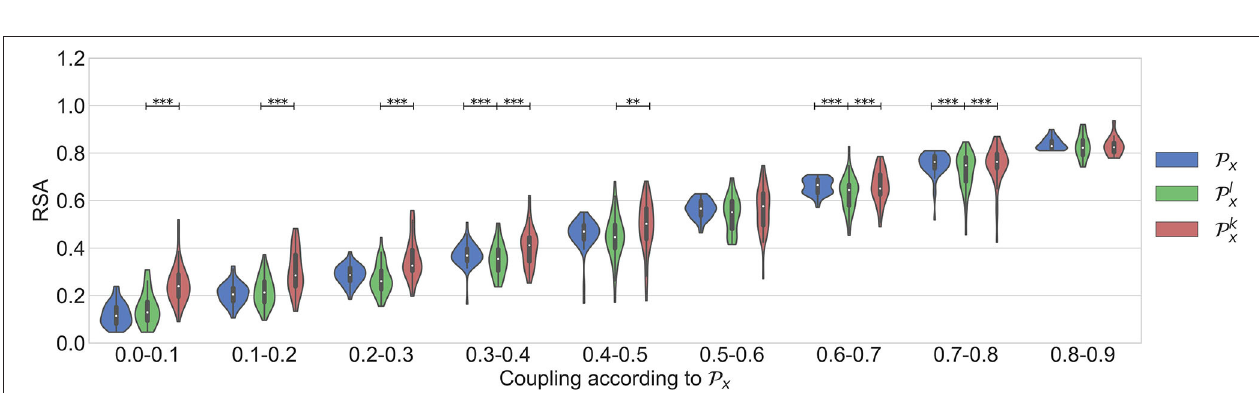
FIGURE 3 | Results obtained in simulation 1. C 1 models the strength of the linear part of the coupling. C 2 models the nonlinear part. The figure on top shows the results in scenario 1, when C 2 = 0. The bottom plot is the scenario when C 2 = 2 − C 1 . In both cases, C 1 is varied in the interval [0 1.8], in steps of 0.2.